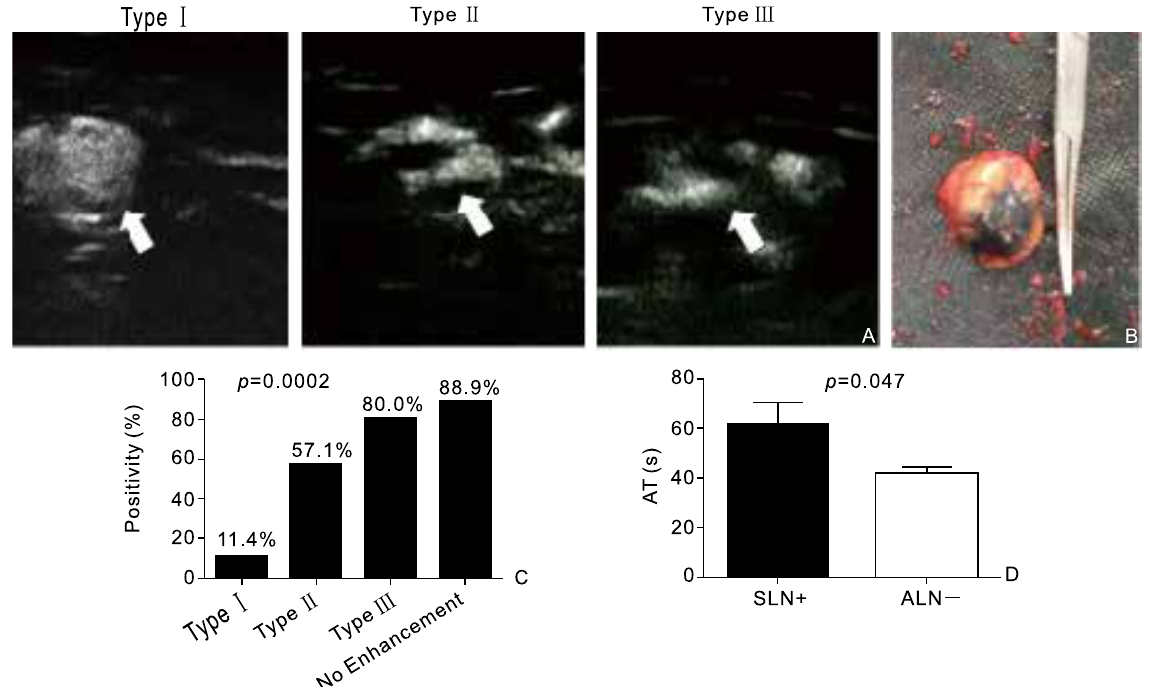
Figure 1 TLCEUS/blue dye injection method is sensitive and specific for SLNB. A) Different contrast pattern of SLNs observed by TLCEUS; B) Sample of dissected SLNs with obvious blue dye; C) Lymph nodes with type II and type III contrast pattern, and lymph nodes without enhancement are more likely to be metastasis positive; D) Positive SLNs showed a longer AT between contrast agent injection and lymph node enhancement than negative SLNs. TLCEUS, trans-lymphatic contrast enhanced ultrasound; SLNs, sentinel lymph node; AT, arriving time. A p value less than 0.05 is considered as statistically